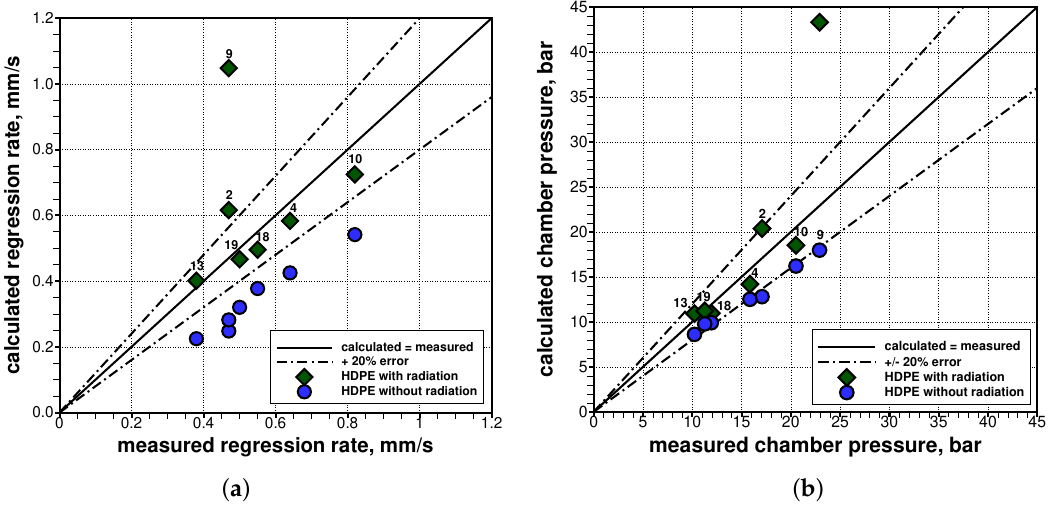
Figure 9. Comparison of computed values from simulations (with and without radiative energy exchange) with measured data from the experimental firings: ( a ) time- and space-averaged regression rates; ( b ) time-averaged chamber pressures. Table 12. Computed average results (gas–surface interaction with radiation). Test